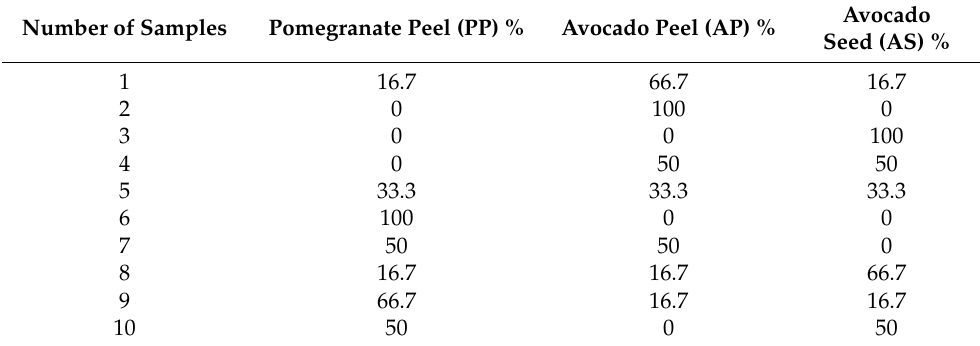
Table 6. Design Table (randomized) with the concentrations,